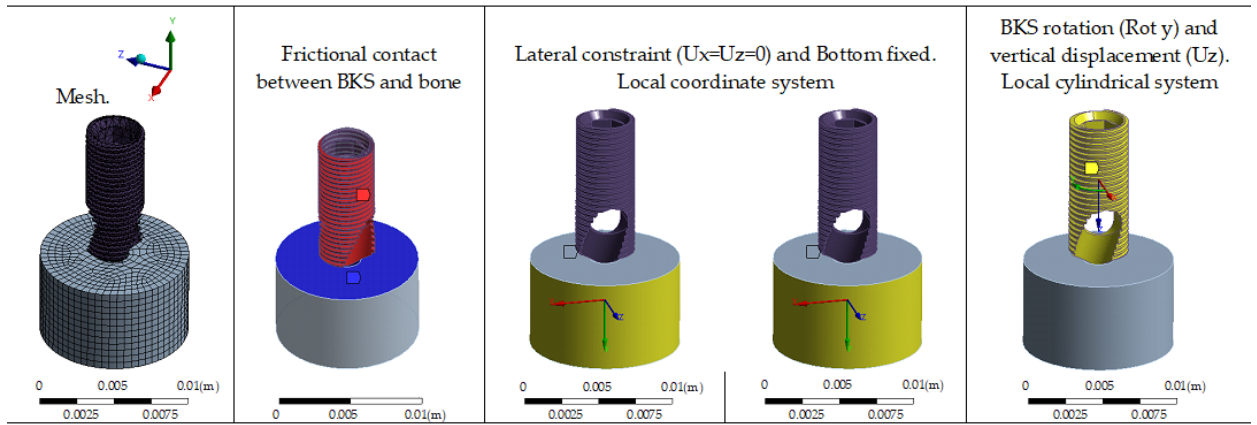
Figure 2. Explicit dynamic analysis: Boundary conditions and mesh.